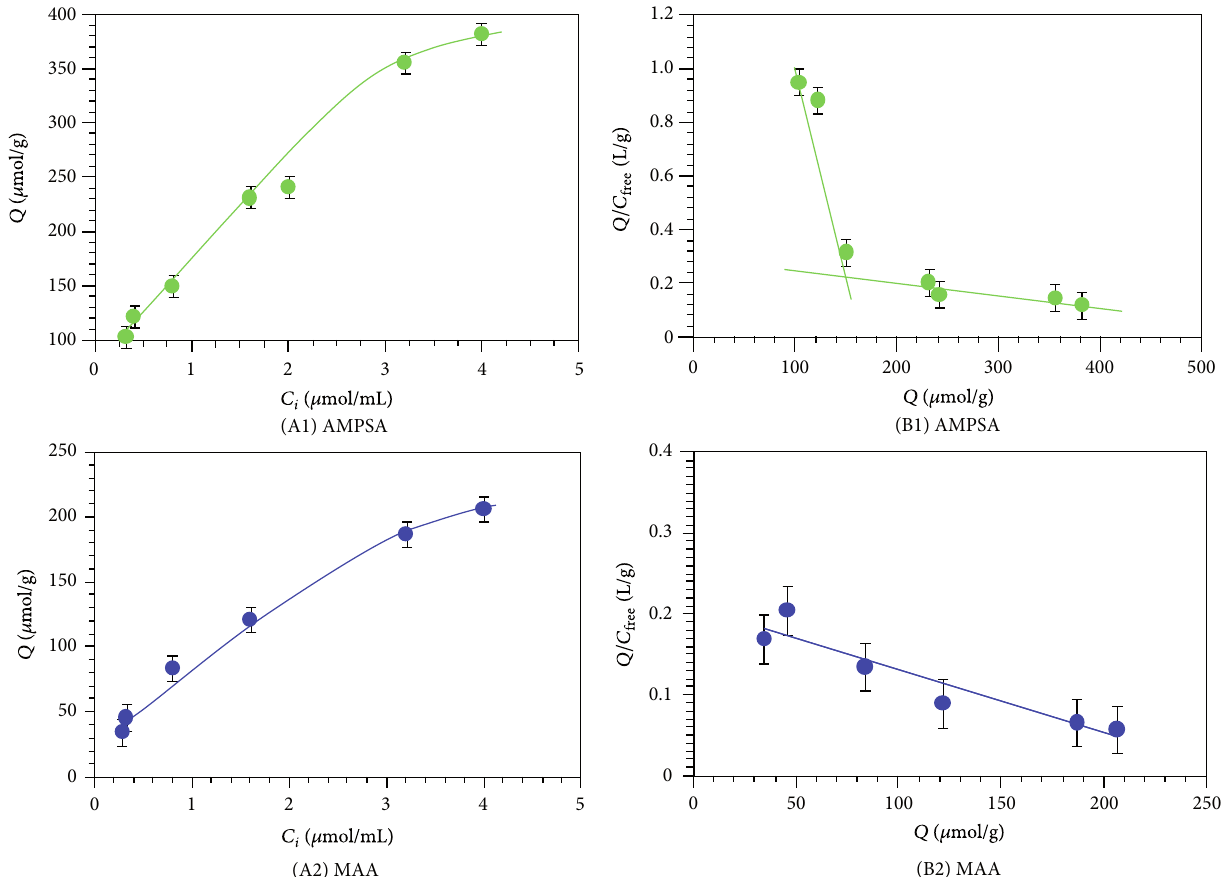
is the amount of LMG bound to 20.0mg of the 𝑄𝑄